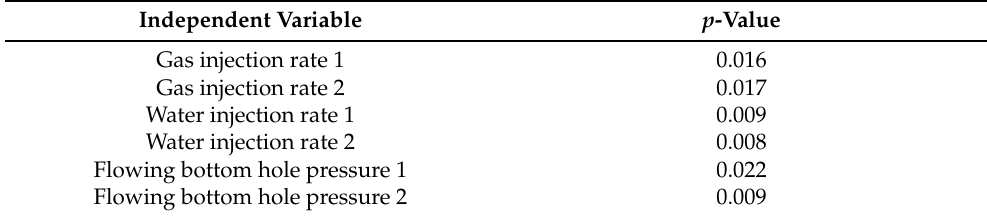
Table 4. Correlation analysis